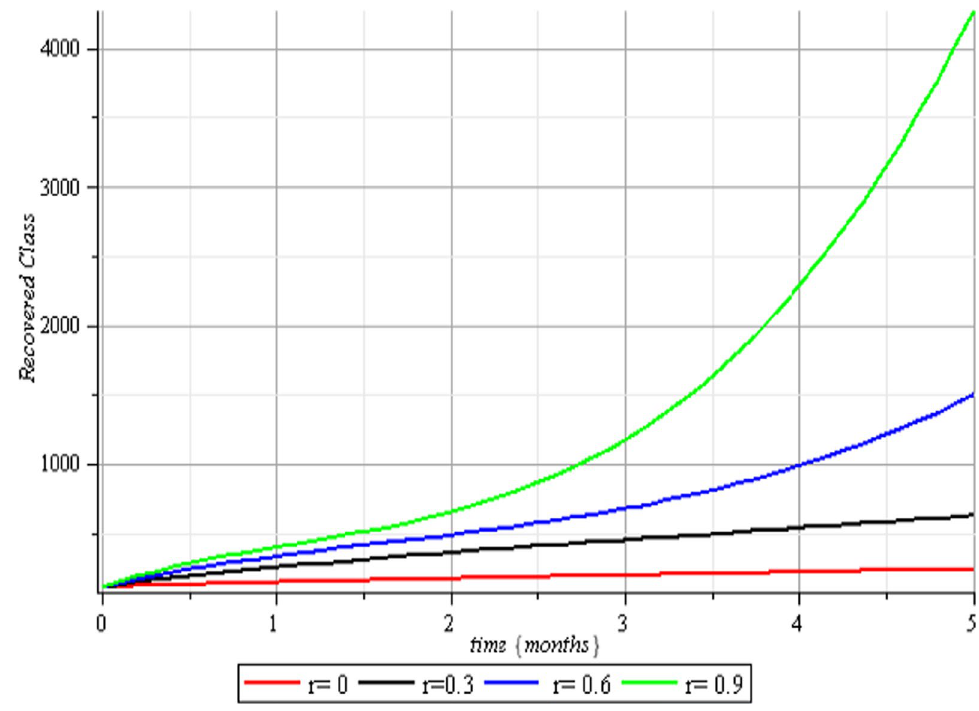
Fig. 6 Therapeutic effects on the recovered class